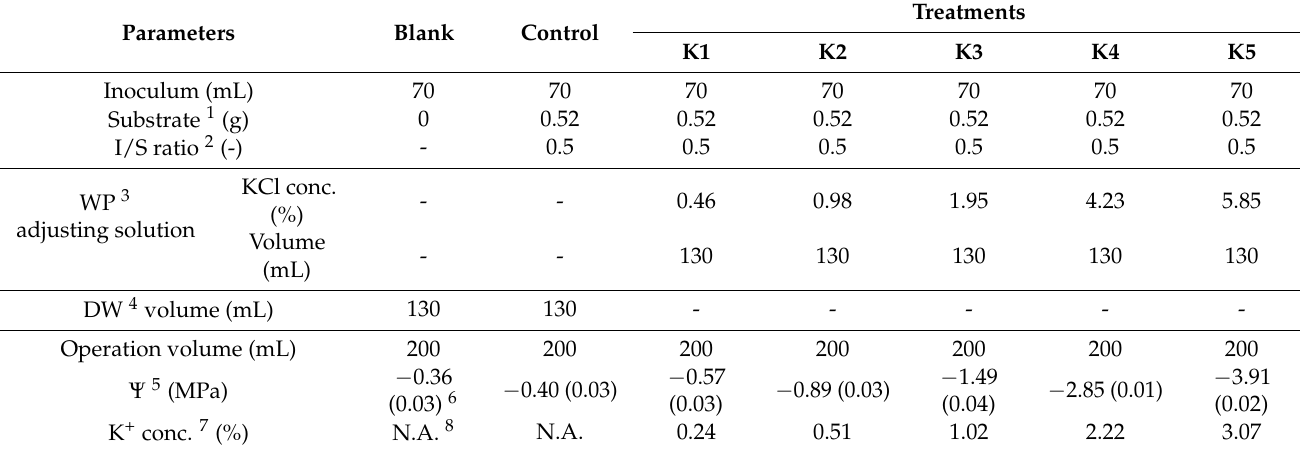
Table 3. Experimental conditions for the water potential ( Ψ ) inhibition